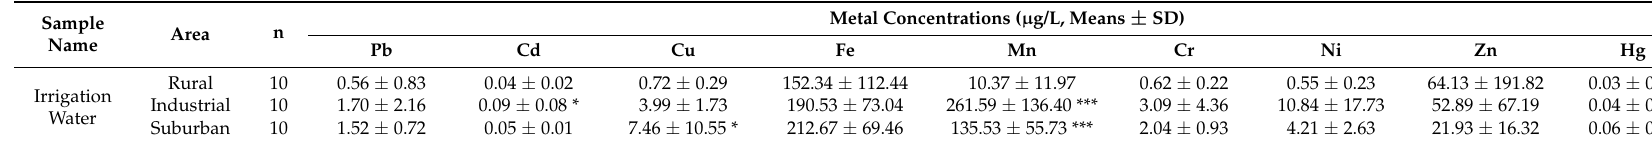
Table 5. Metal concentrations in irrigation